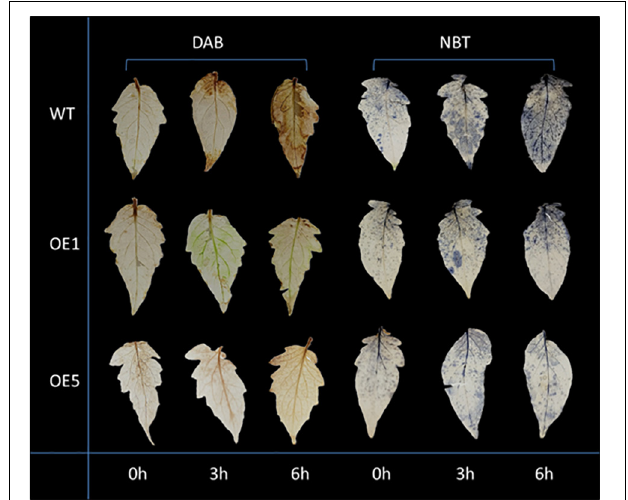
FIGURE 5 | DAB and NBT staining of tomato leaves. The yellow and blue colors both represent superoxide accumulation. that most of the genes had significantly upregulated responses after drought stress. The flavonoid biosynthesis pathway, as a phenylpropanoid biosynthesis downstream metabolic pathway, was relatively active in the OE lines and was also the significantly